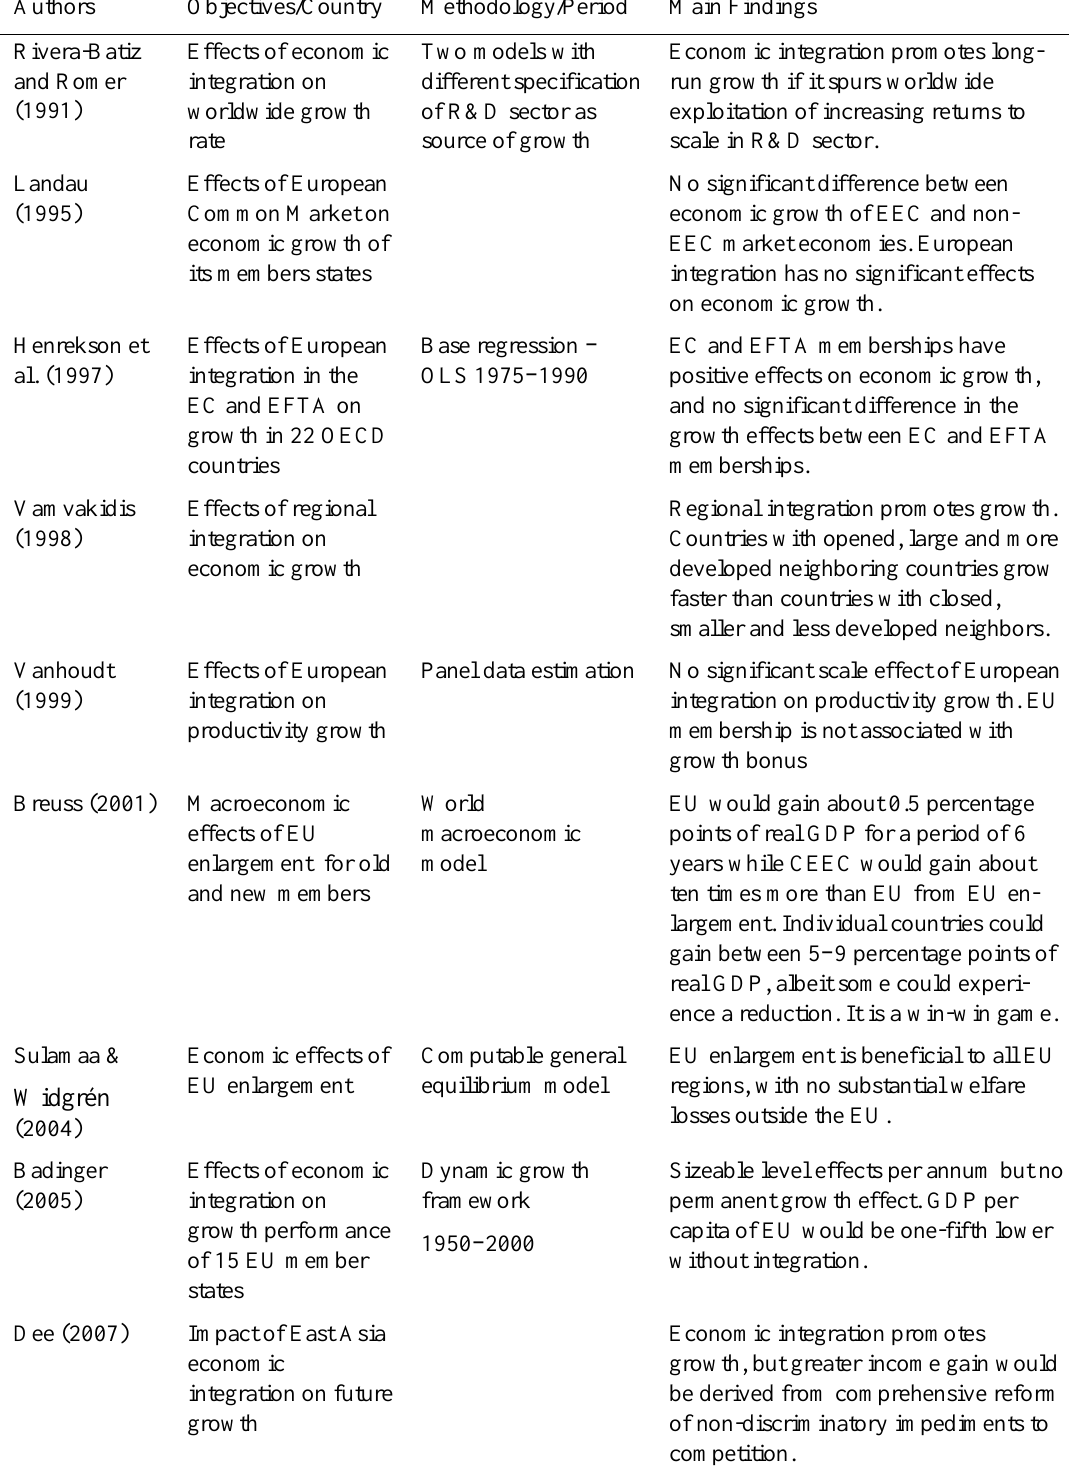
Table 1: Summary of recent studies on the effects of economic integration on economic growth Authors